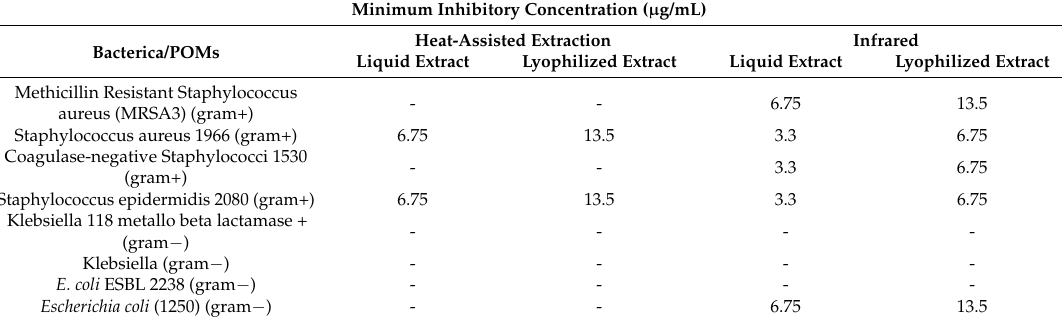
Table 1. Minimum inhibitory concentration ( µ g/mL) of different Gram-positive and Gram-negative bacteria from heat-assisted extraction (HAE) and infrared (IR) apricot pomace extracts (liquid and